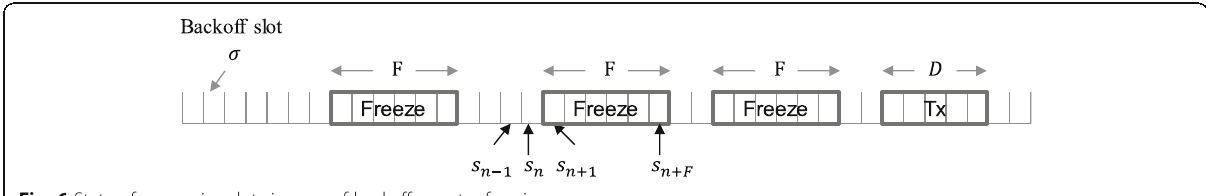
Fig. 6 State of successive slots in case of backoff counter